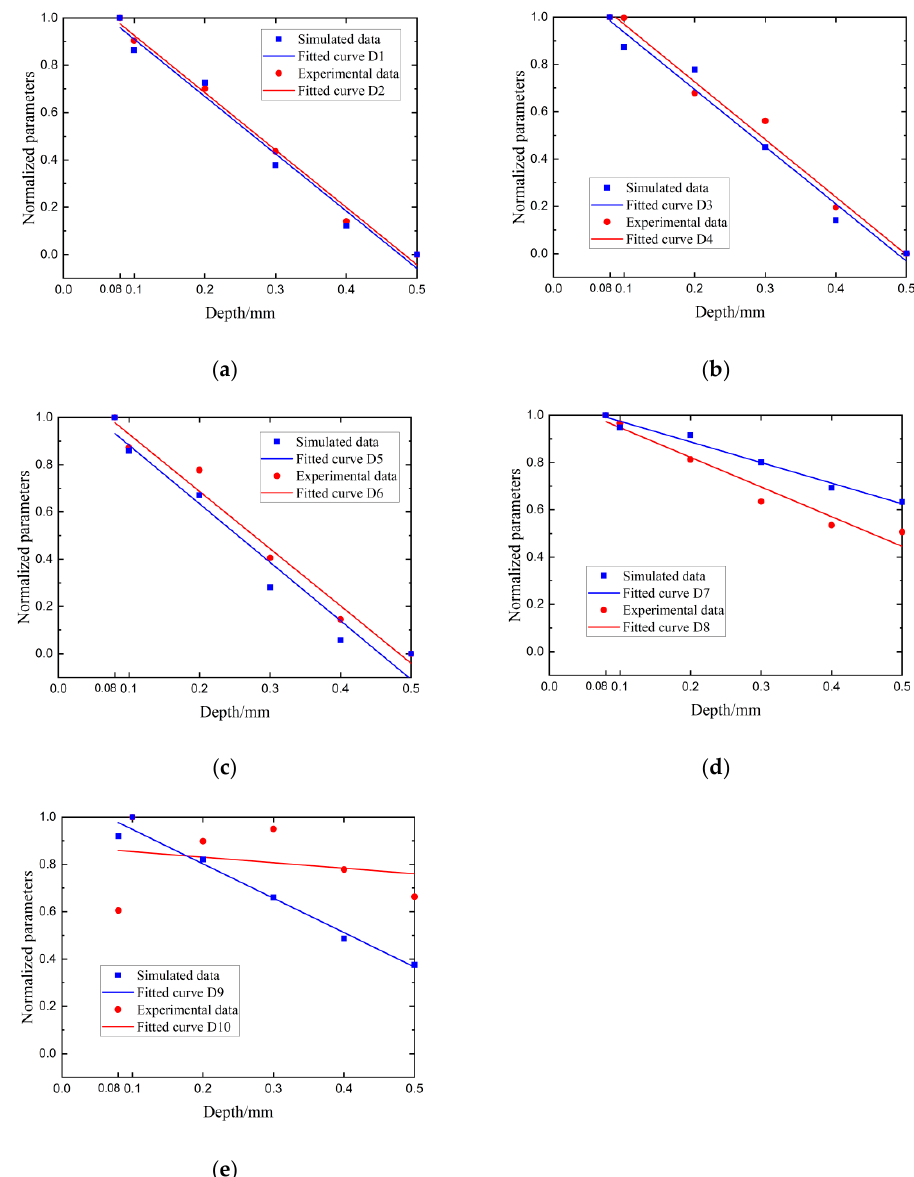
Figure 13. Crack-depth normalized parameters in ( a ) 1.0 MHz–2.6 MHz, ( b ) 1.0 MHz–2.0 MHz, ( c ) 1.5 MHz–2.6 MHz, ( d ) 0.5 MHz–2.6 MHz, and ( e ) 0.5 MHz–3 MHz .